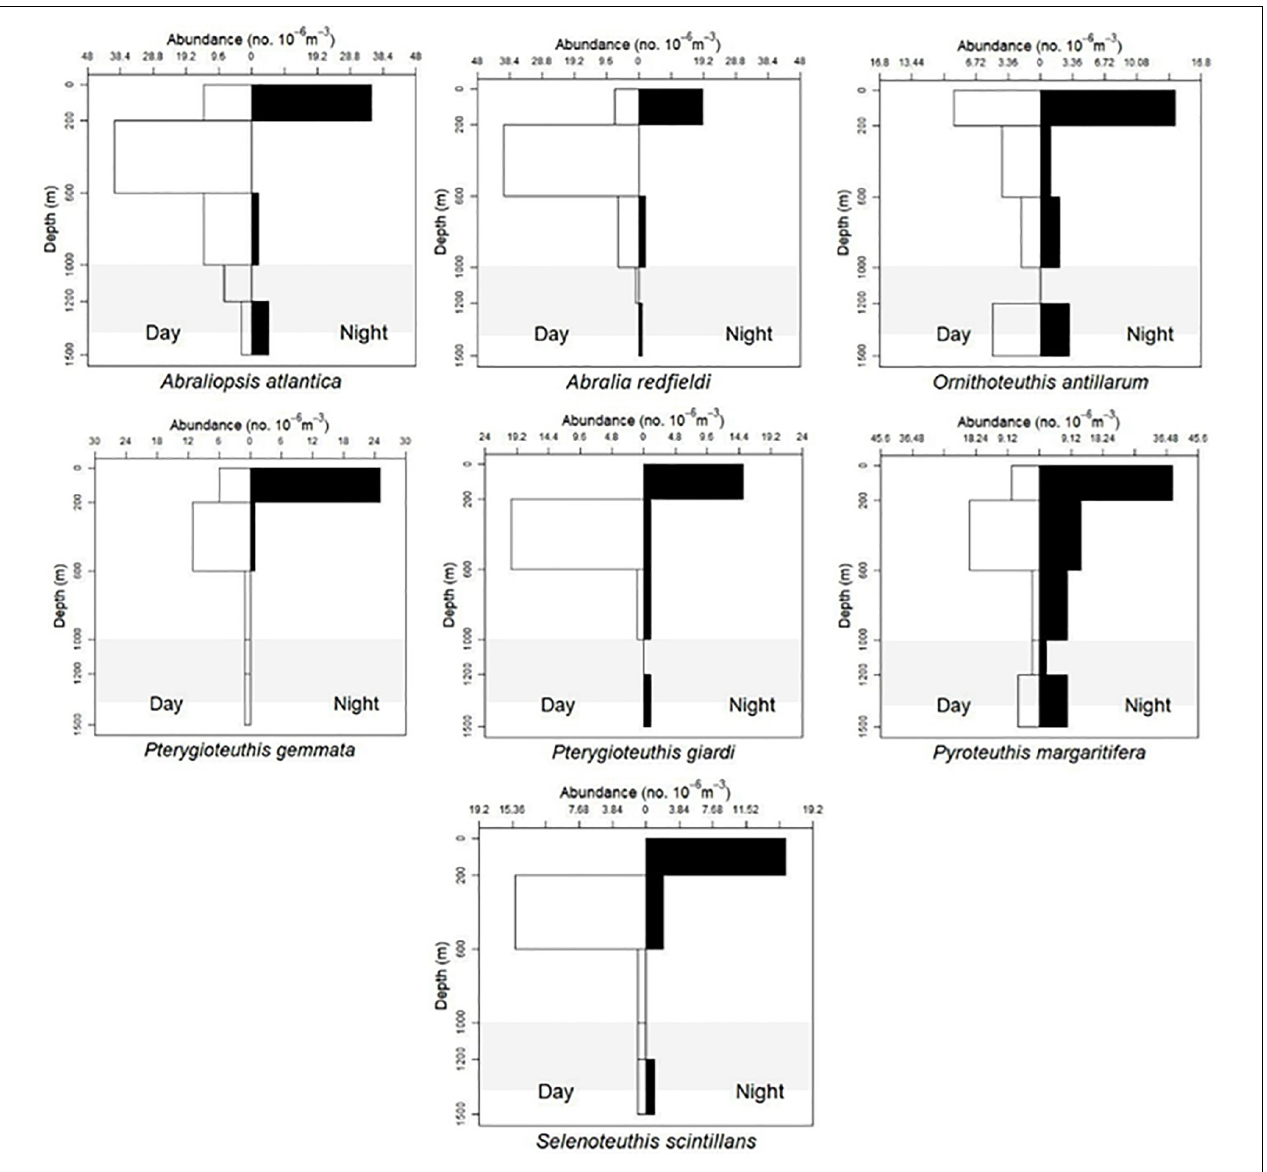
FIGURE 4 | Vertical distribution patterns of seven cephalopods. Nyctoepipelagic synchronous diel migration described by T. Sutton et al. (unpublished). A. atlantica , n = 32; A. redfieldi , n = 70; O. antillarum , n = 39; P. gemmata , n = 45; P. giardi , n = 40; P. margaritifera , n = 106; S. scintillans , n = 37; shaded region indicates the deep oil plume